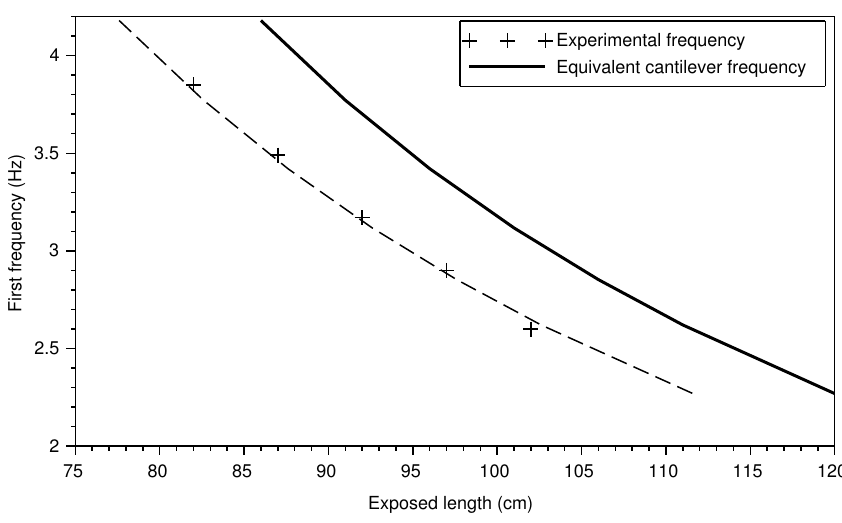
Figure 6. Variation of the first frequency with the exposed length H of the